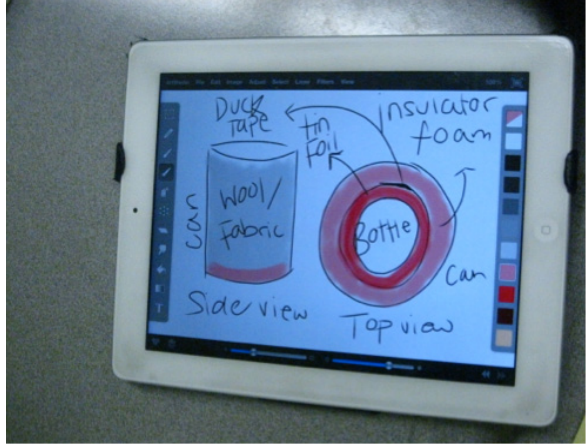
Figure 6. Example of student design using a